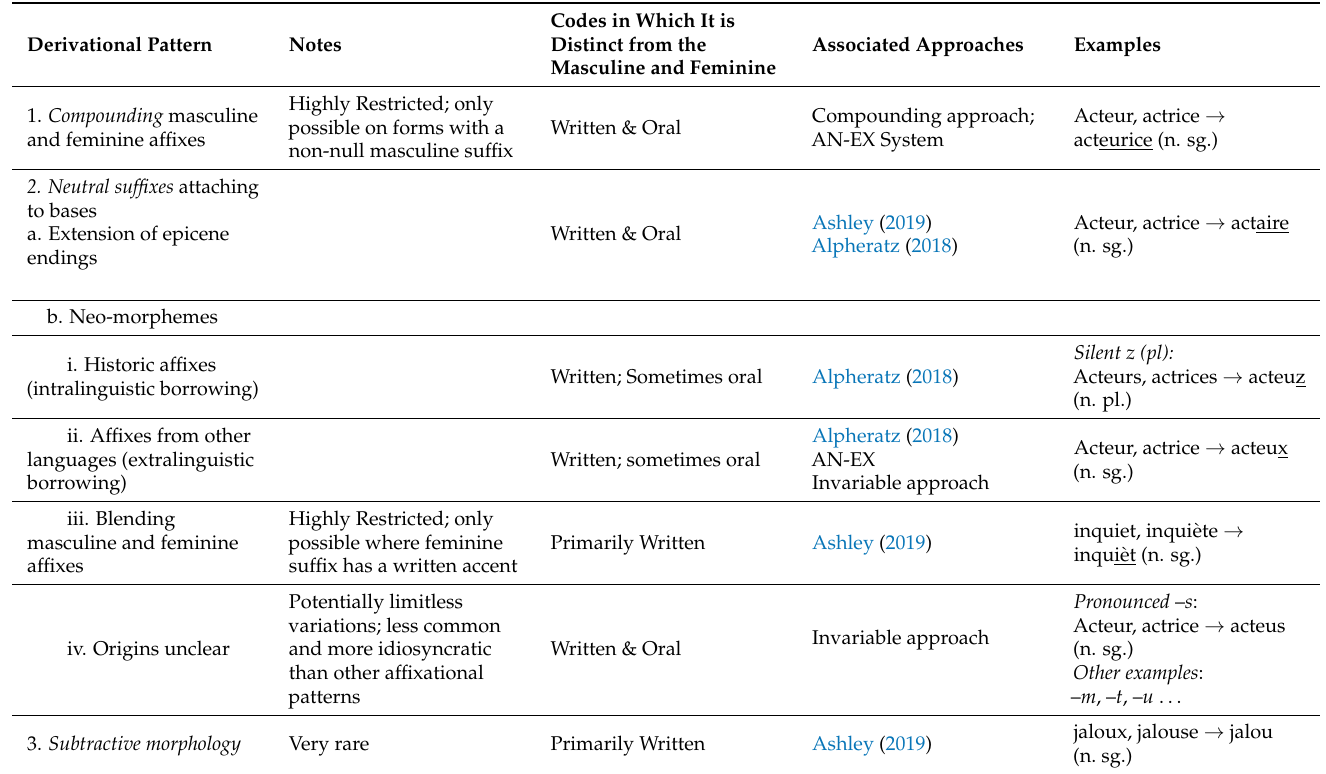
Table 8. Patterns of Deriving Non-binary